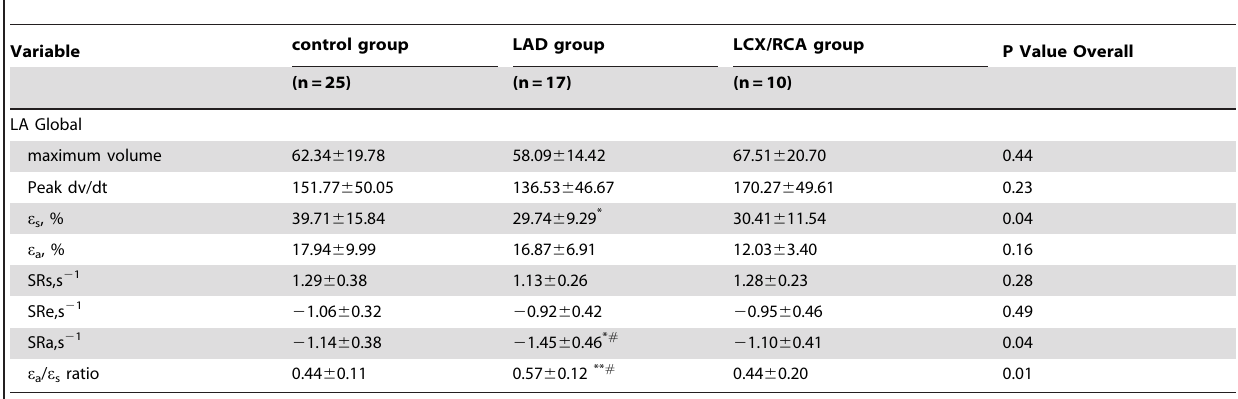
Table 4. Global deformation analysis of LA by the distribution pattern of obstructive coronary artery.